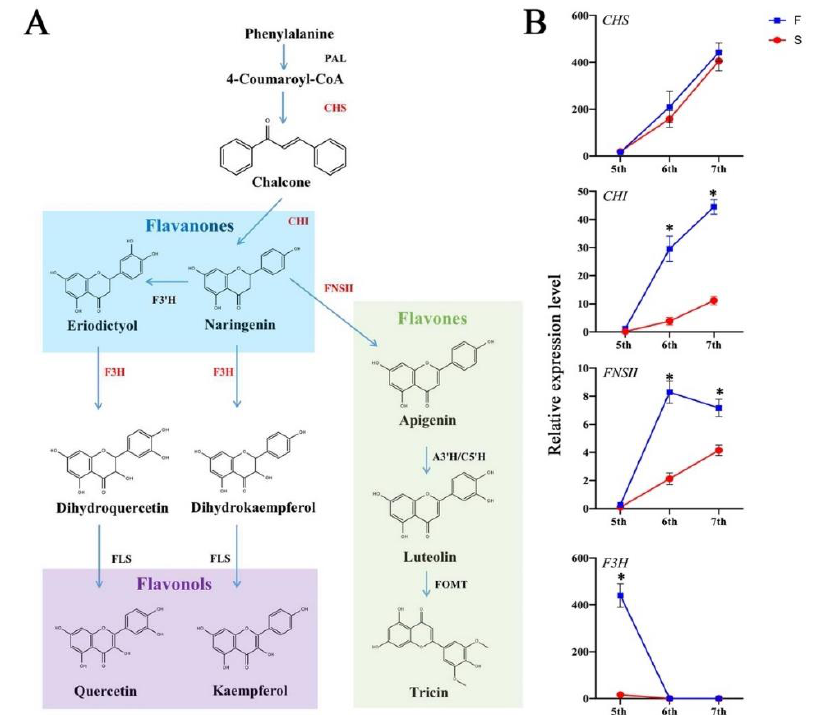
Figure 9. Rice flavonoid biosynthesis pathways and expression of genes encoding key enzymes. ( A ) Rice flavonoid biosynthesis pathway. ( B ) The relative expression level of genes encoding key en-